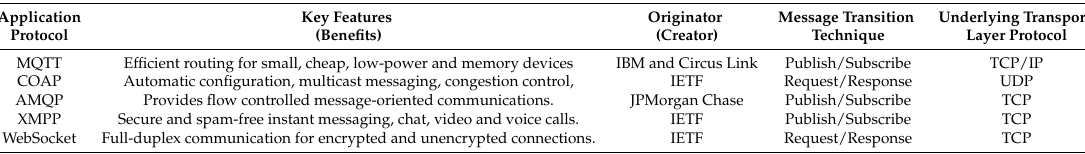
Table 6. Comparison of adaptable application layer protocols for marine communication